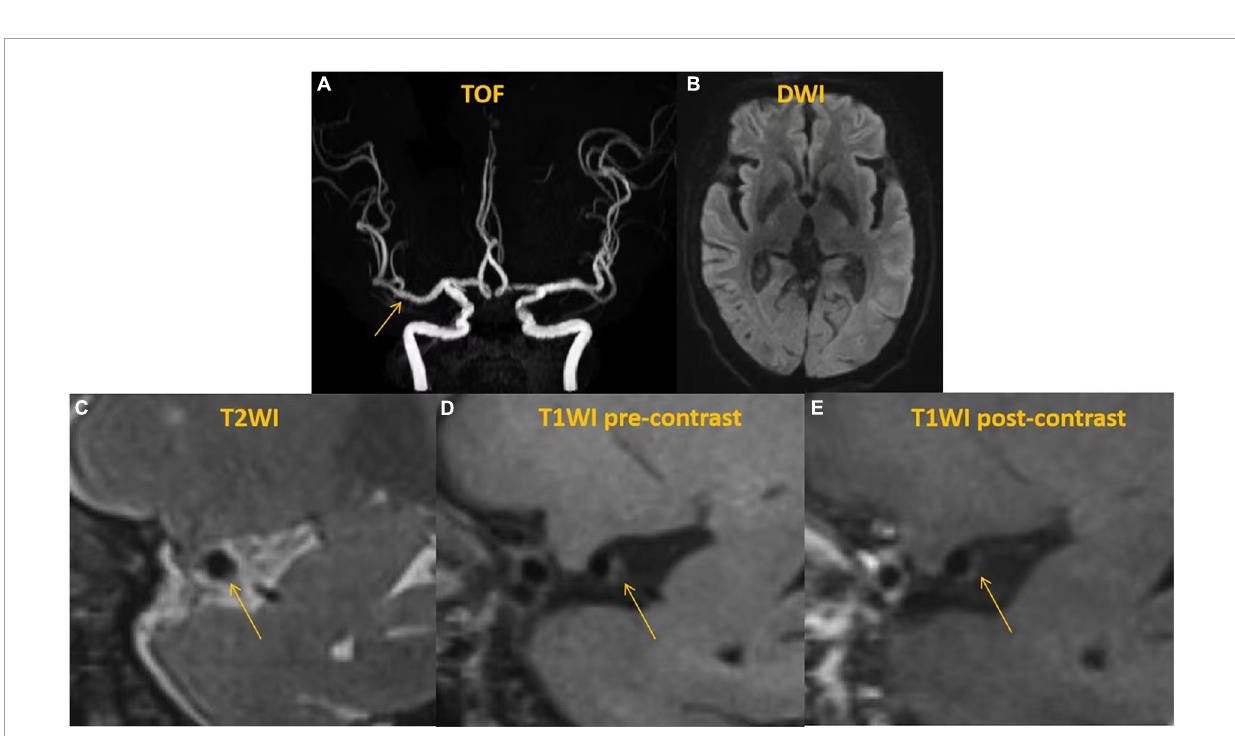
FIGURE2 A 62 years-old man without any neuro symptom. Time-of-flight (TOF)-magnetic resonance angiography (MRA) (A) demonstrated a normal appearance. DWI (B) showed no acute infarct with the anterior circulation territory. High-resolution vessel wall MRI (hr-vw MRI) including T2-weighted image (C) , pre-contrast T1-weighted image (D) and post-contrast T1-weighted image (E) visualized the plaque on the posterior and inferior side of the right middle cerebral artery (MCA). The plaque showed isointense on T2-weighted image (C) and pre-contrast T1-weighted image (D) and no enhancement on post-contrast T1-weighted image (E)